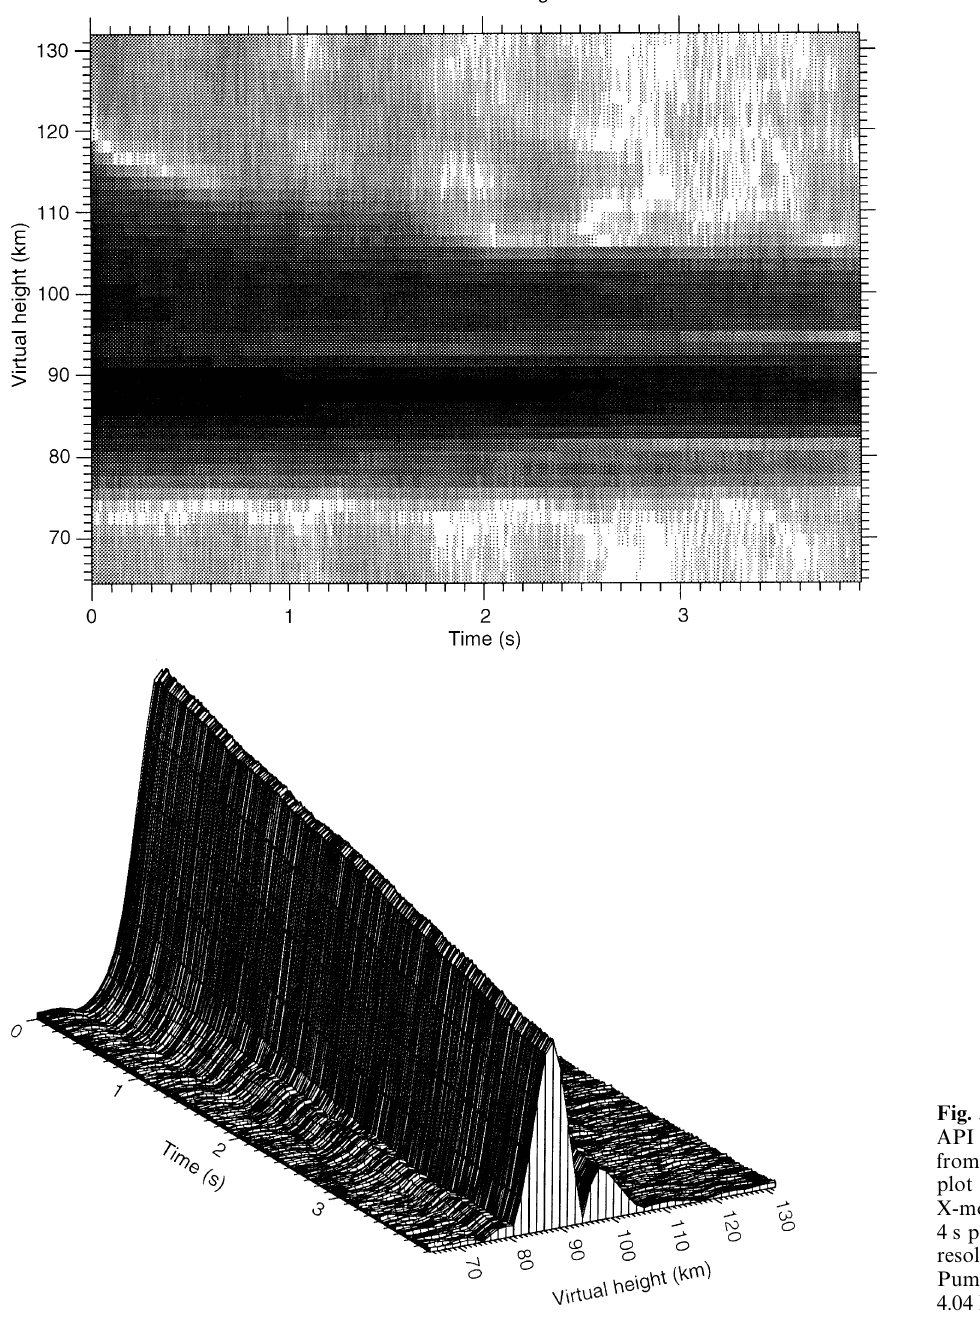
Fig. 3. Grey-scale and surface plot of API echoes between 80 and 120 km from 18 November 1993. The surface plot shows linear amplitude. The X-mode HF pump had been on for 4 s prior to the 0-s tick. The vertical resolution is 4.5 km in these data. Pump and probing waves were